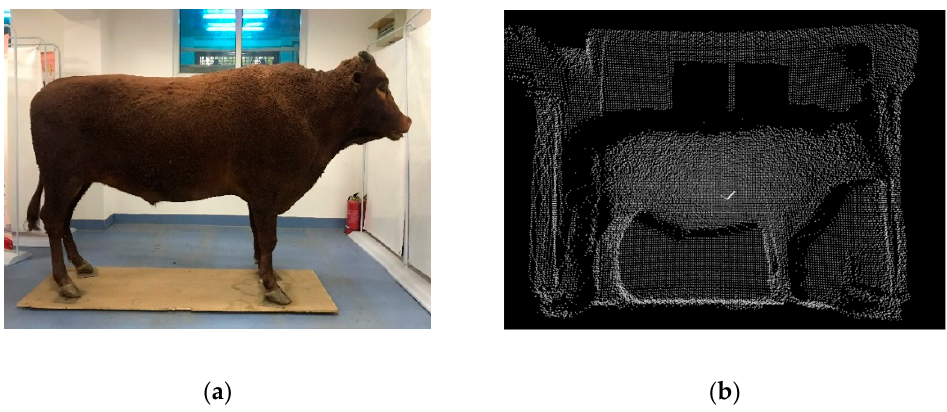
Figure 5. 3D PCD (Point Cloud Data) acquisition for Qinchuan cattle (real specimen) with the LiDAR sensor where the 3D image shows the basic silhouette of the target cattle. ( a ) Shown in RGB; ( b ) Shown in 3D image.